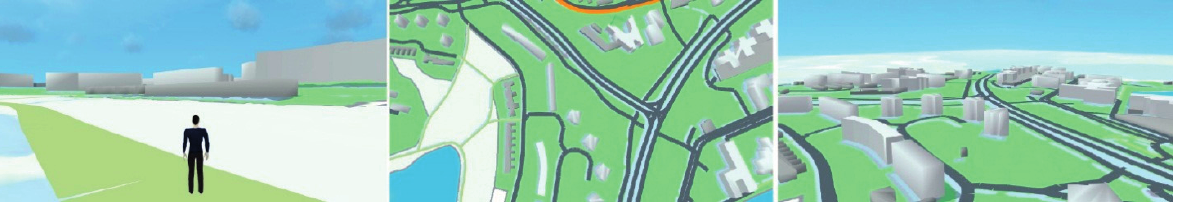
Figure 7. The Meshmoon scene can be navigated using an avatar, an aerial camera, or a free-flying